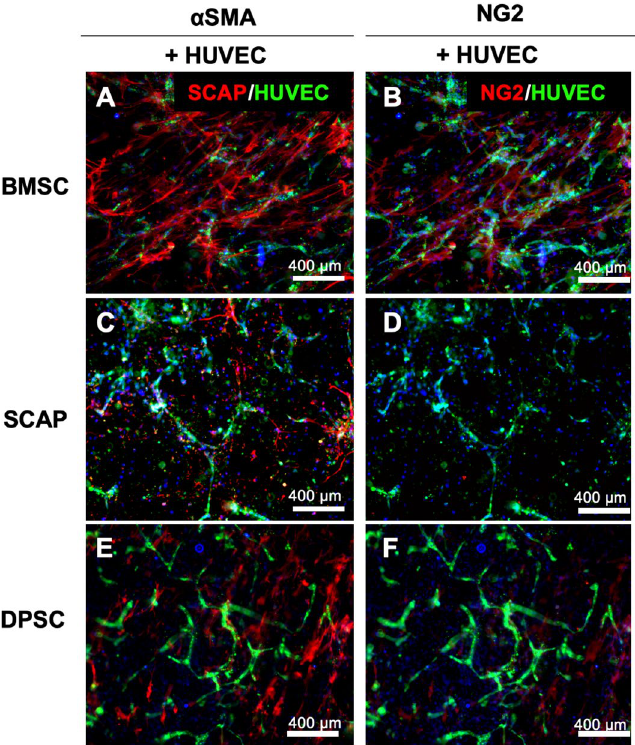
Figure 5. Early marker (NG2) and late marker (α-SMA) staining of differentiated stem cells. While BMSC showed the distribution of both cells ( A , B ), the DPSC ( C , D ) and SCAP ( E , F ) showed marked absence of NG2 positive